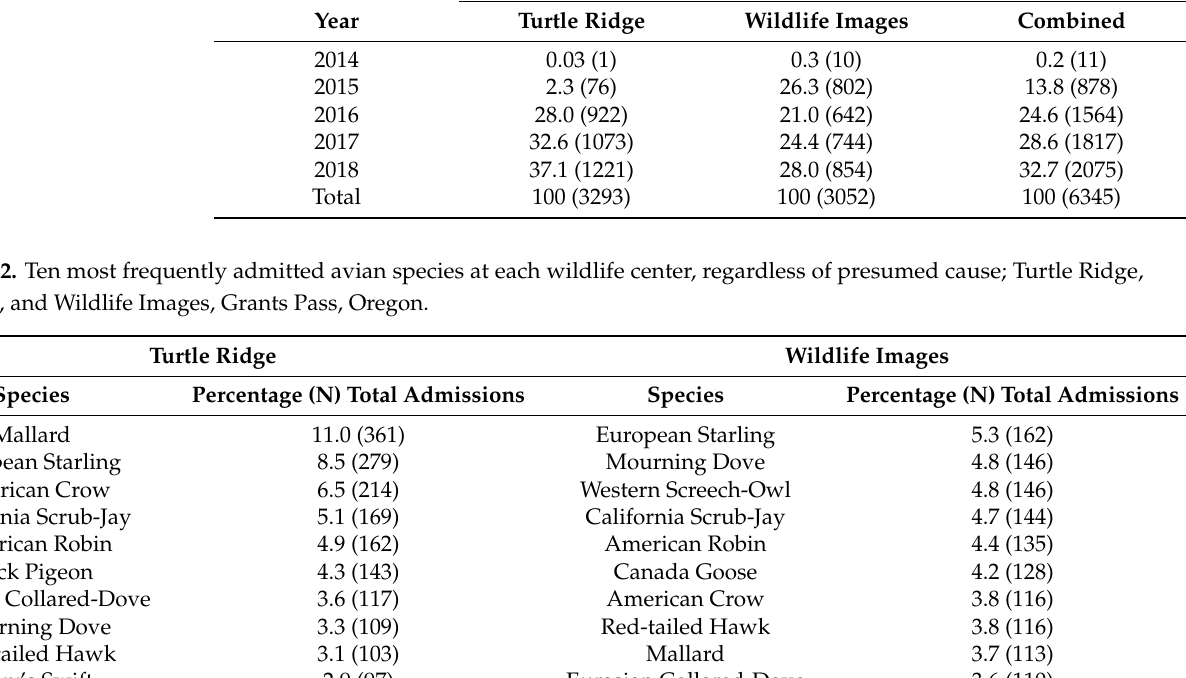
Table 1. Total annual admissions to the rehabilitation centers (N) and the percentages of those admissions that were birds.